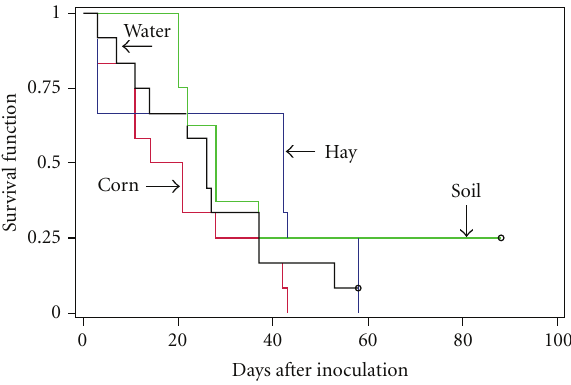
Figure 7: Survival probabilities of M. bovis in water, corn, hay, and soil across all seasons tested.